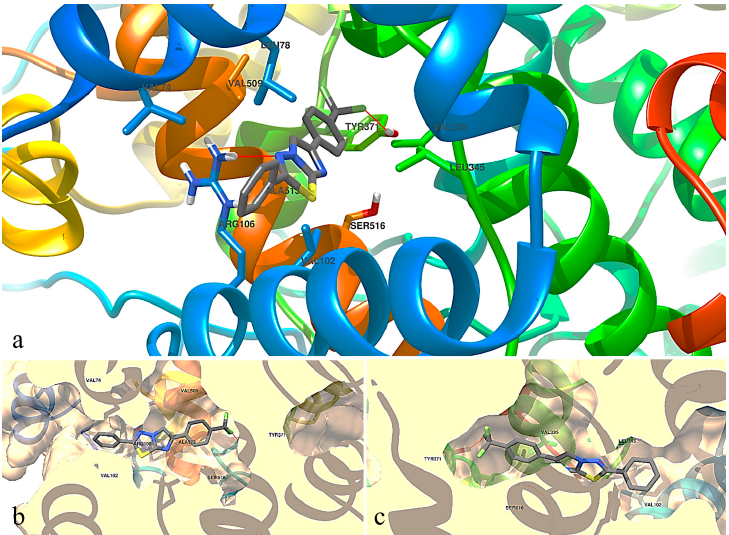
Figure 3. The top binding pose of compound 5c docked to the catalytic site of COX-2. In section ( a ) of